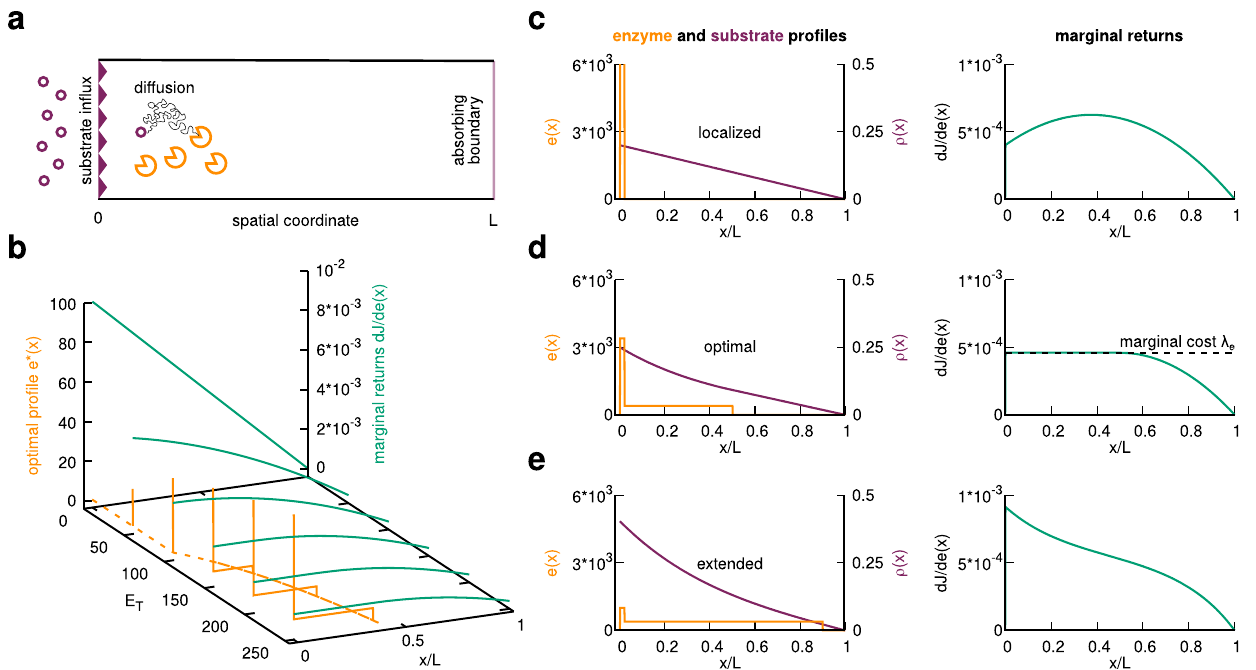
Fig. 2 Homogeneous Marginal Returns (HMR) criterion for the optimal spatial allocation of enzymes. a Illustration of the analytically solvable 1D model with a source of substrate at x = 0 and an absorbing boundary at x = L . Within the system, the substrate diffuses and can react with the spatially arranged enzymes. b Optimal enzyme pro fi le with corresponding marginal return landscape at different total enzyme amounts E T (the reaction-diffusion parameter is fi xed to α = 10 − 2 ). c – e Different enzyme and substrate pro fi les (left) with corresponding marginal returns (right) for E T = 400. c Localized con fi guration. The marginal returns landscape is peaked at x > 0, indicating that enzymes should be moved away from the source. d Optimal pro fi le with constant marginal return over the region with enzymes (HMR criterion). In the constant region, the marginal return is equal to the marginal cost λ e of adding extra enzymes into the system. e Overextended pro fi le. Monotonically decreasing marginal return, indicating that enzymes should be moved towards the source at x =